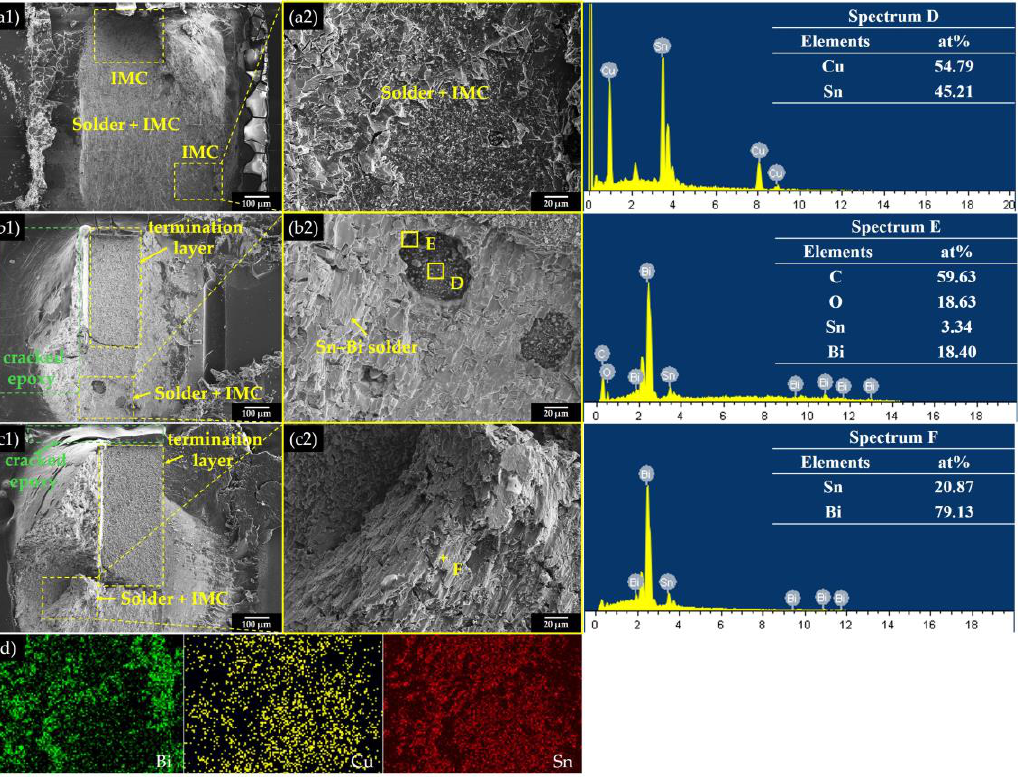
Figure 9. SEM and EDS analysis of solder joints, ( a1 , a2 ) Sn – Bi solder joint after TC 1000 cycles; ( b1 , b2 ) TSEP Sn – Bi-5 solder joint after TC 1000 cycles and ( c1 , c2 ) TSEP Sn – Bi-5 solder joint after TH 1000 h; ( d ) EDS mapping of ( a2 ).